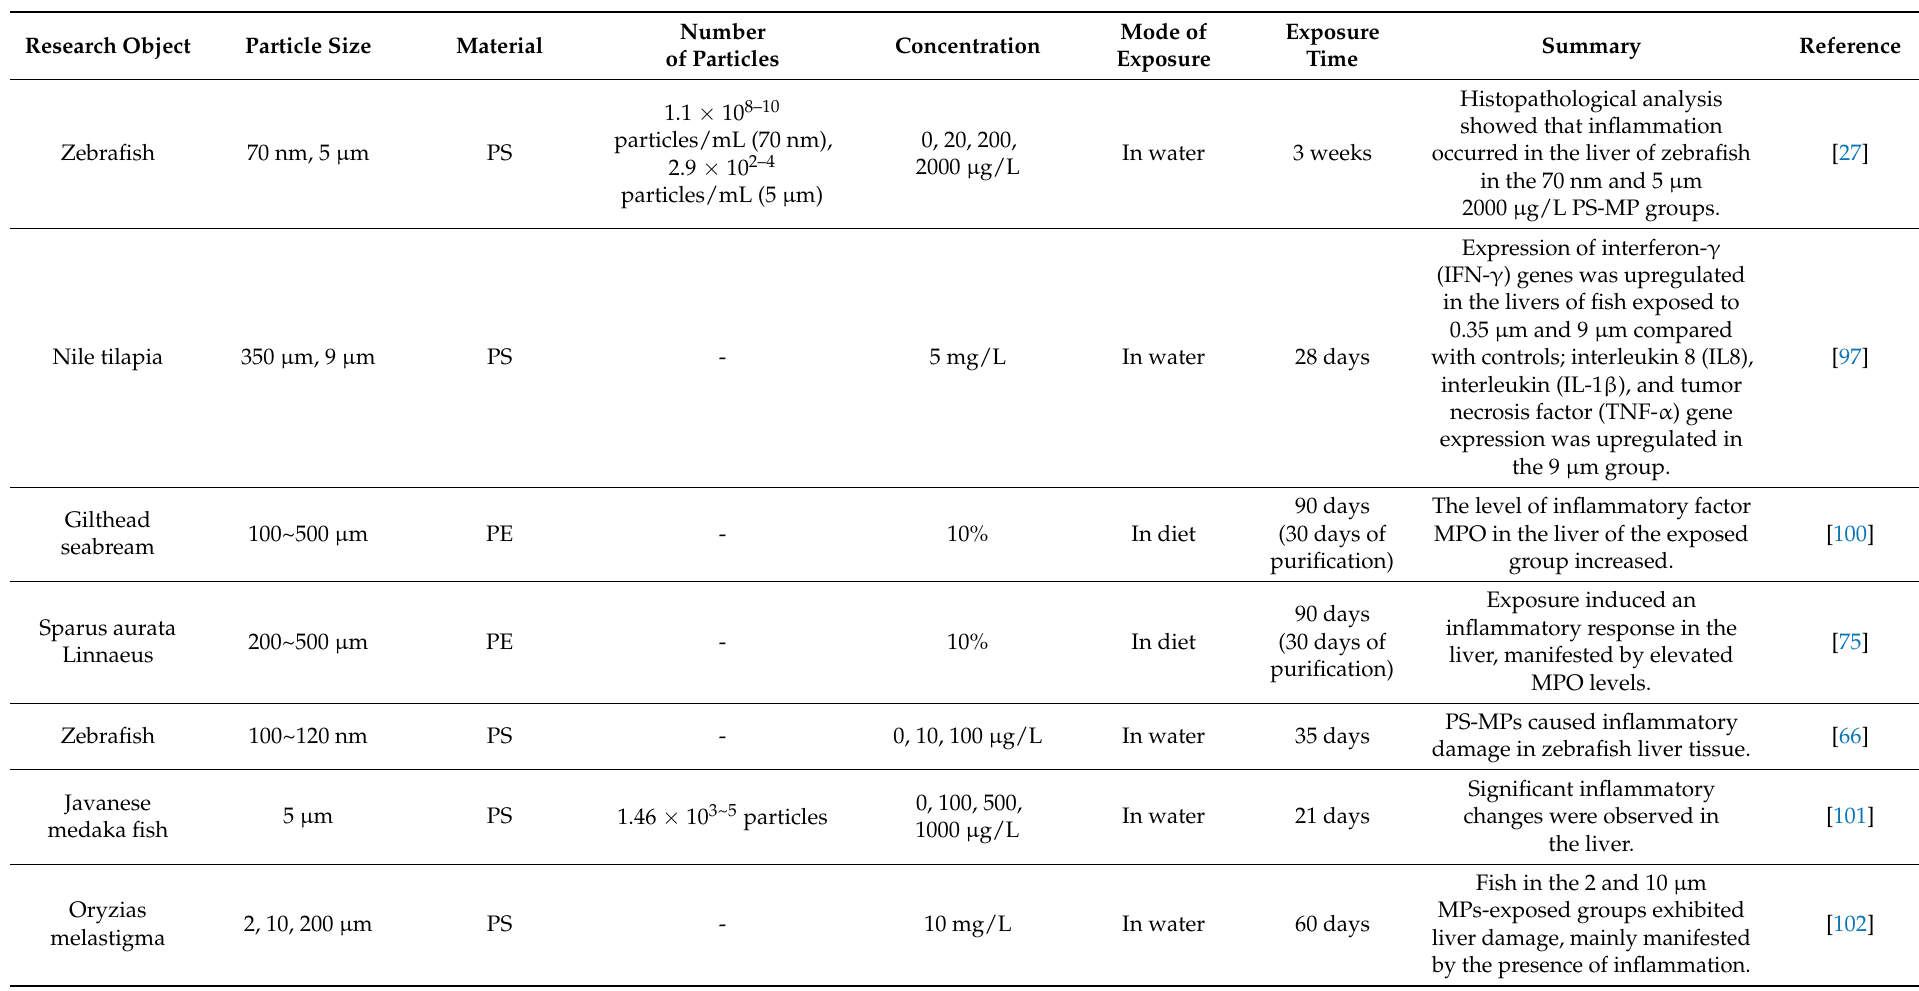
Table 5. The study parameters and effects of MPs and NPs on liver